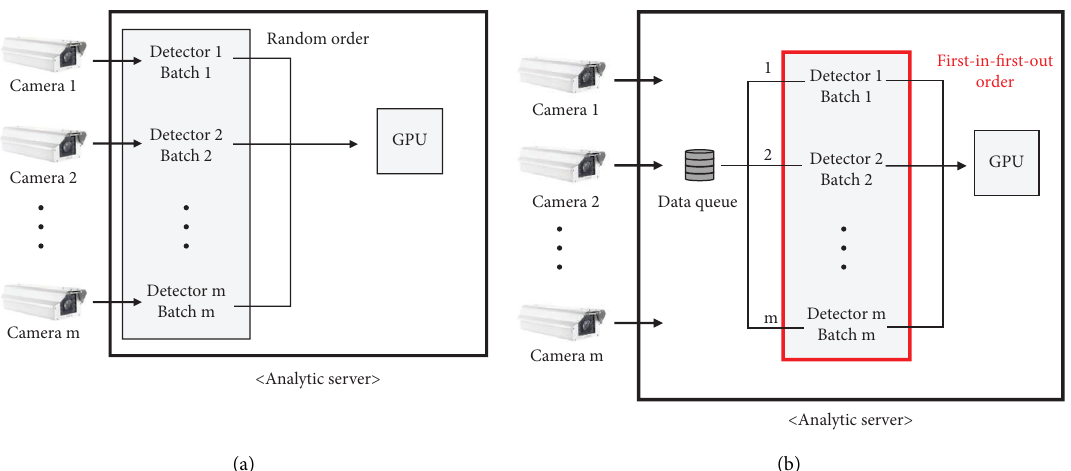
Figure 1: Data processing method: (a) random order process method and (b) frst-in-frst-out order process method (proposed system).